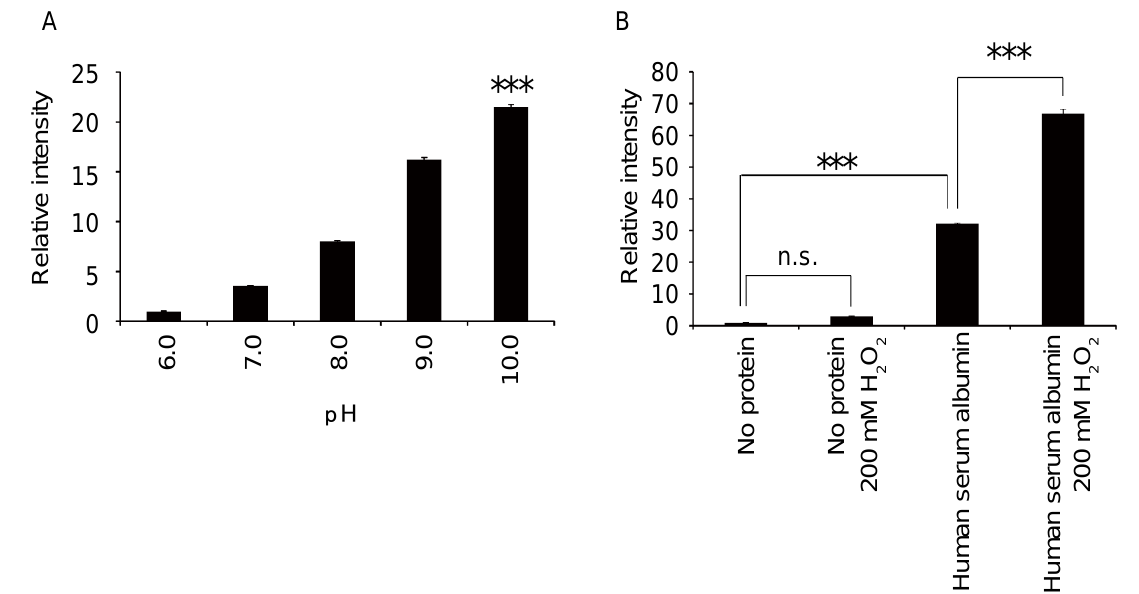
Figure 2. ( A ) Relative changes in the luminescence intensity of the albumin–luciferin reaction at each pH value (80 mM, Tris) (mean ± SEM, n = 4; one-way ANOVA with Dunnett’s test, *** p < 0.001). ( B ) Relative changes in the luminescence intensity of the albumin–luciferin reaction with or without 200 mM hydrogen peroxide (mean ± SEM, n = 4; one-way ANOVA with Tukey’s test, *** p < 0.001, n.s. = not significant).